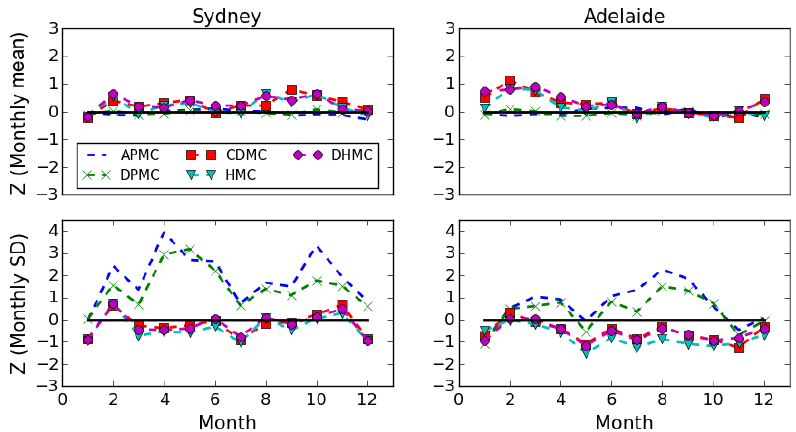
Figure 8. Comparison of the mean and SD of monthly rainfall depths for the five MC